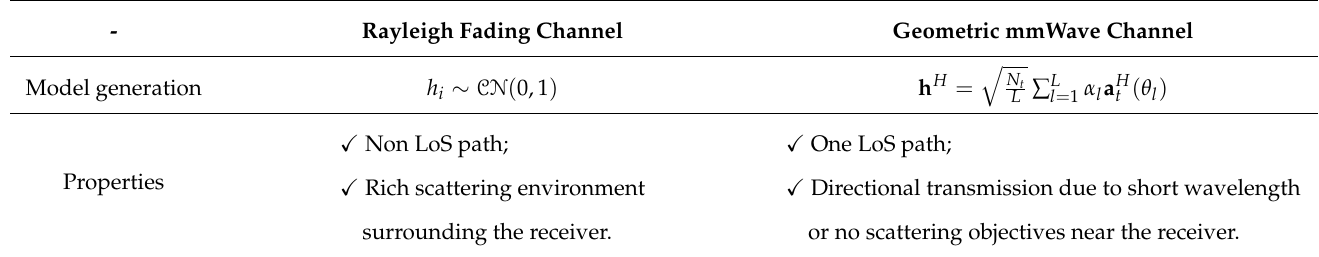
Table 4. Channel Models for Algorithm